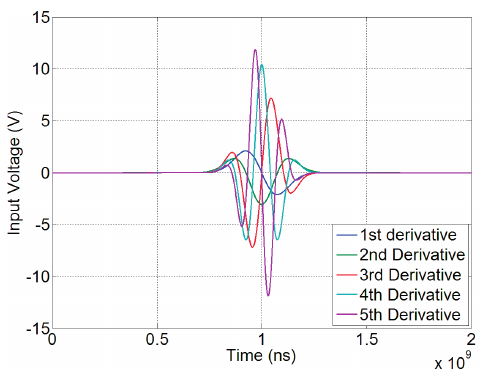
Figure 8. Admissible spectral density for the exciting pulses.